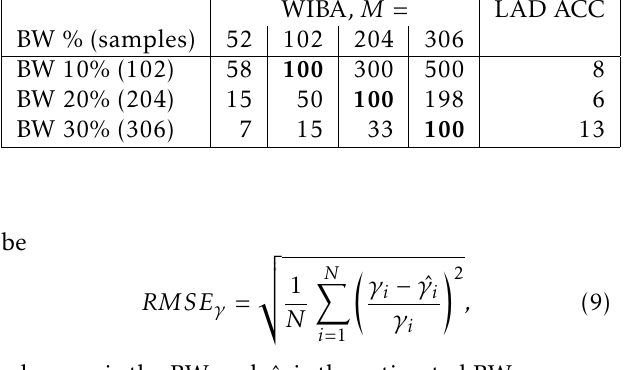
Table 4. Relative Mean Square Error (RMSE) [%] in the one signal scenario for 10 , 20 , and 30% bandwidth when M = 52 , 102 , 204 and 306 . Figure 6. RMSE vs. SNR results for the case when bandwidth of the signal is 10% WIBA, M = LAD ACC